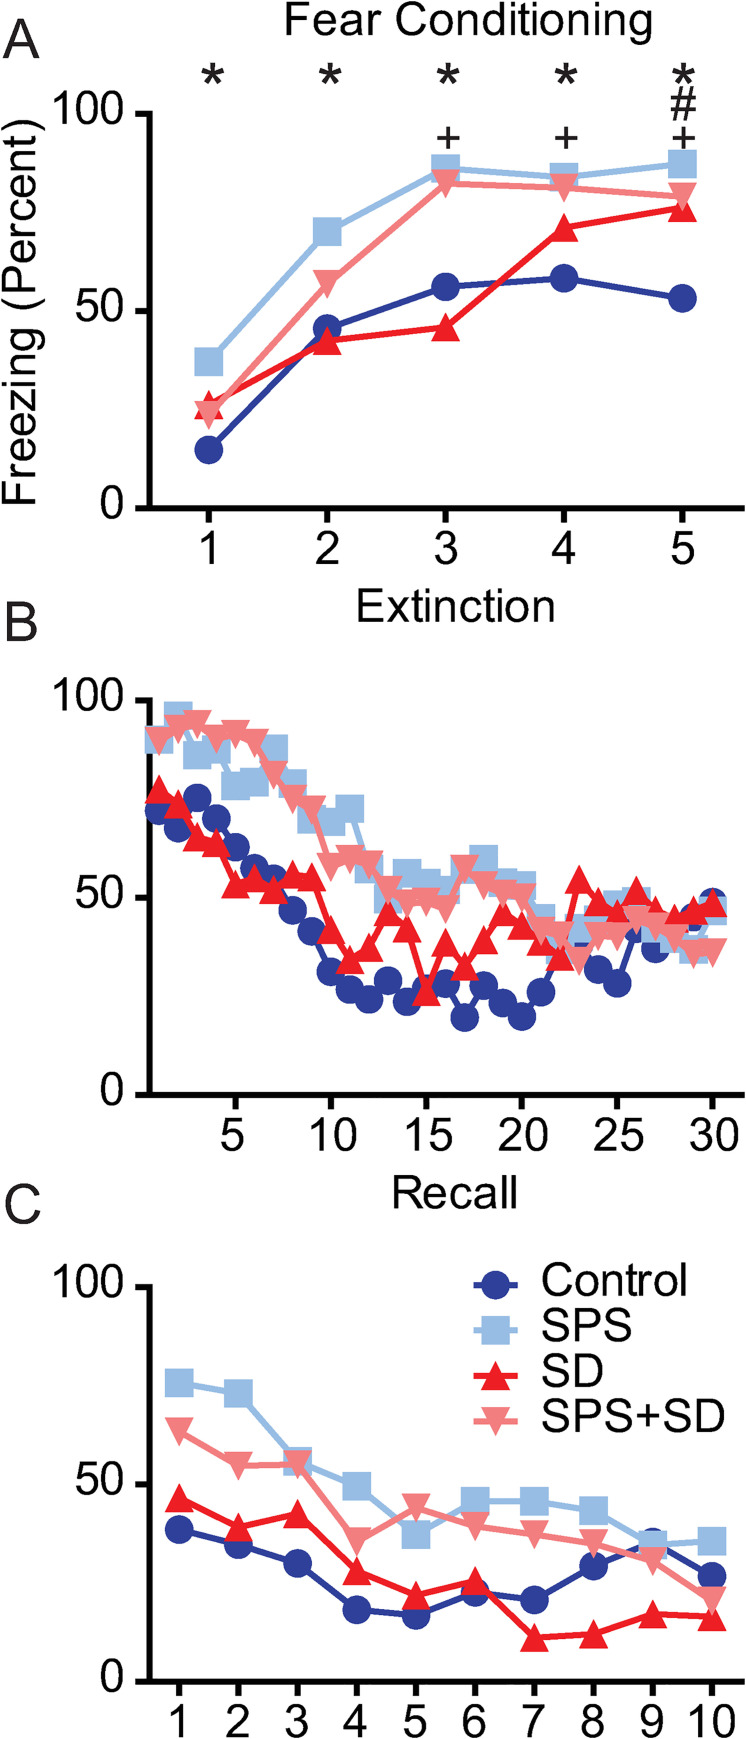
SPS exposure significantly alters the timeline of fear-associated memory training, extinction, and recall.Each line represents the freezing duration (percent) over each 1 min period of the fear conditioning, extinction, and recall phase of the fear-associated memory test. Each phase was analyzed with two-way ANOVA followed by Bonferroni post-hoc analysis that compared control animals (dark blue circles) to animals exposed to SPS (light blue squares), or SD (dark red triangles), or a combination of SPS+SD (light red triangles). A) two-way ANOVA revealed a significant group x time interaction (F(12,148) = 3.14, P = 0.0005) on the fear conditioning day, B) the extinction day, (F(187,1073) = 1.54, P = 0.0015) and, C) the recall day (F(27,333) = 1.63, P = 0.027). Bonferroni post-hoc comparisons revealed significant differences from (dark blue) control animals (P <0.05) and are denoted by * for SPS (light blue), # for SD (red), and + for SPS+SD (light red) animals.